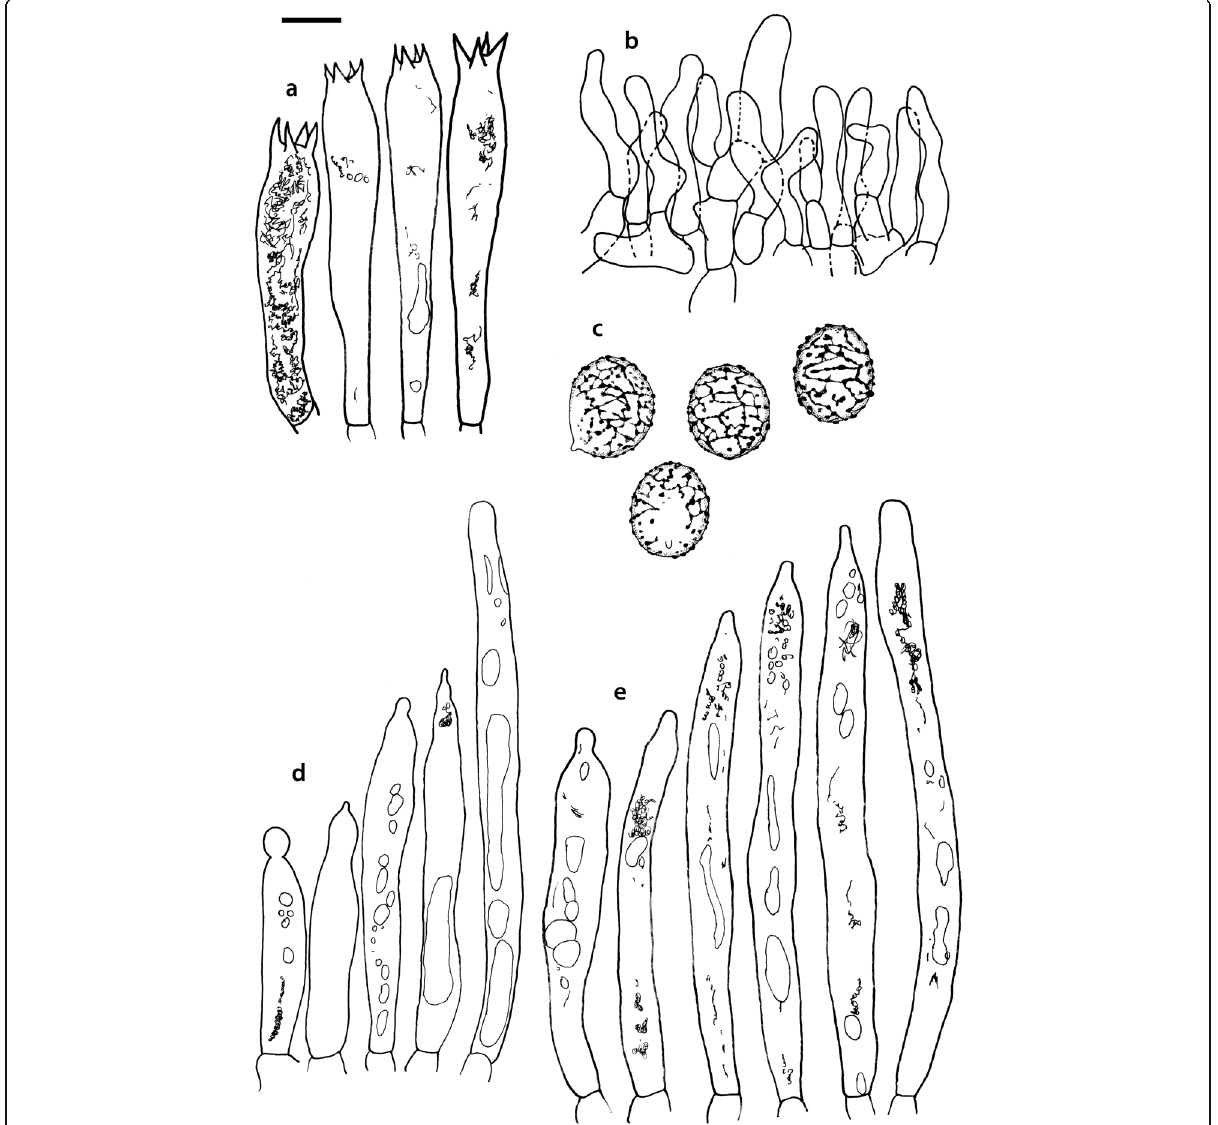
Fig. 4 Russula albonigra (SAV F-755, SAV F-2559, SAV F-20177), hymenium. a Basidia. b Marginal cells. c Basidiospores. d Cystidia near lamellae edges. e Cystidia on lamellae sides. Bar = 10 μ m, except for c 5 μ